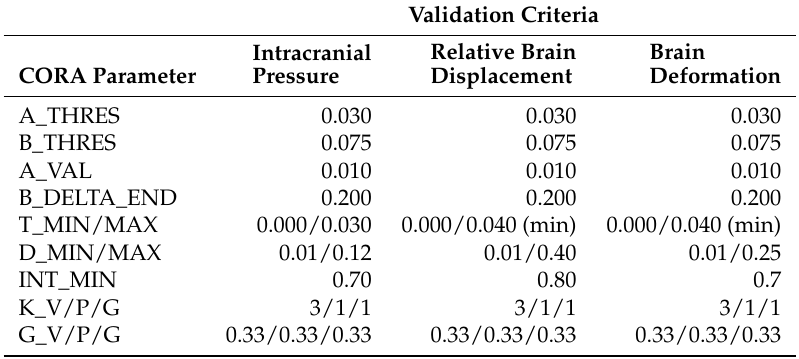
Table 7. Optimised parameters for CORA (ver. 3.6.1) [48] analysis of FEHM performance